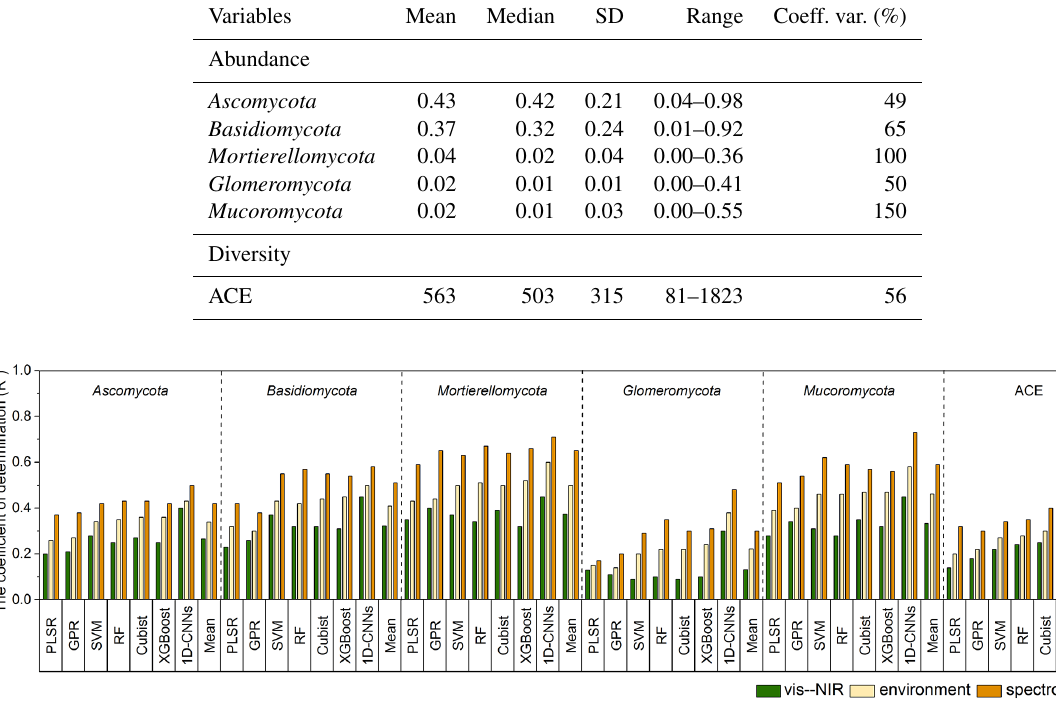
Figure 3. Coefficient of determination ( R 2 ) for the vis–NIR spectroscopic models, soil and environmental models and the spectrotransfer functions that used a combined set of the vis–NIR and readily available soil and environmental covariates used to estimate soil fungal phyla abundance and diversity ( n = 577). The different statistical and machine learning methods were PLSR, GPR, SVM, RF, Cubist, XGBoost and optimised